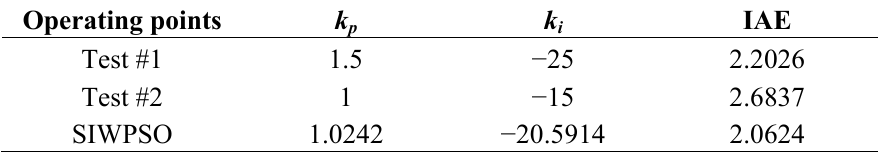
Table 7. The IAE values for the wind turbine generator.